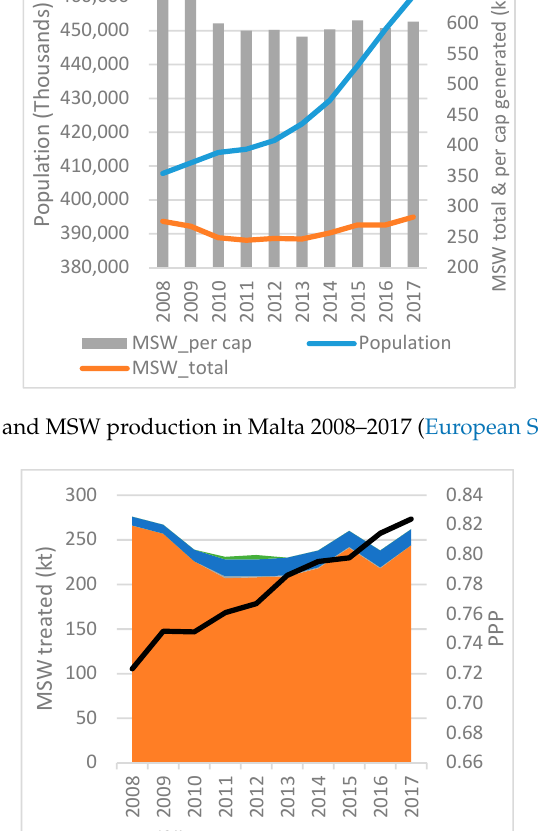
Figure 35. Population and MSW production in Malta 2008–2017 (EUROSTAT 2019a, 2019b).